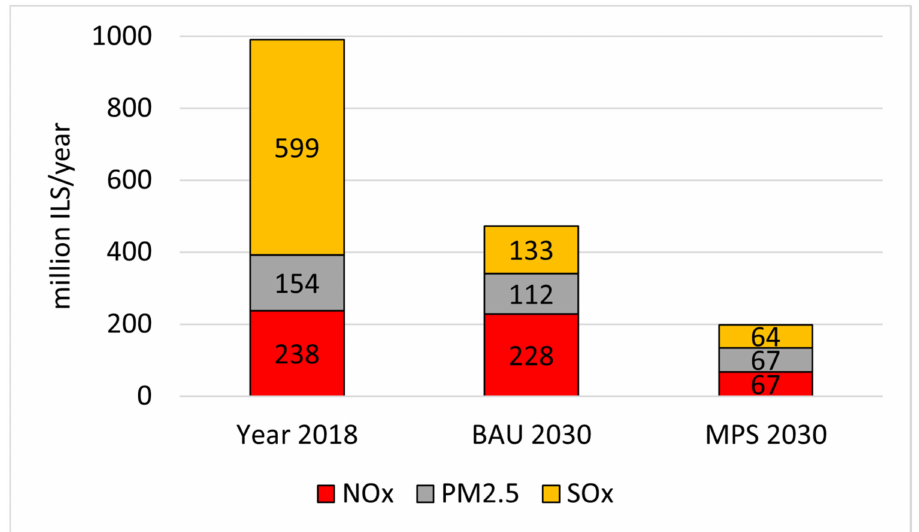
Figure 8. Combined Haifa and Ashdod ports’ air pollution annual damage cost from ships in different scenarios. Scenarios: year 2018 Haifa and Ashdod ports air pollution cost, cost in a business as usual (BAU) scenario for 2030, and cost in the Mitigation Plan Scenario (MPS) scenario for 2030. Y axis values are millions of ILS/year. See Appendix